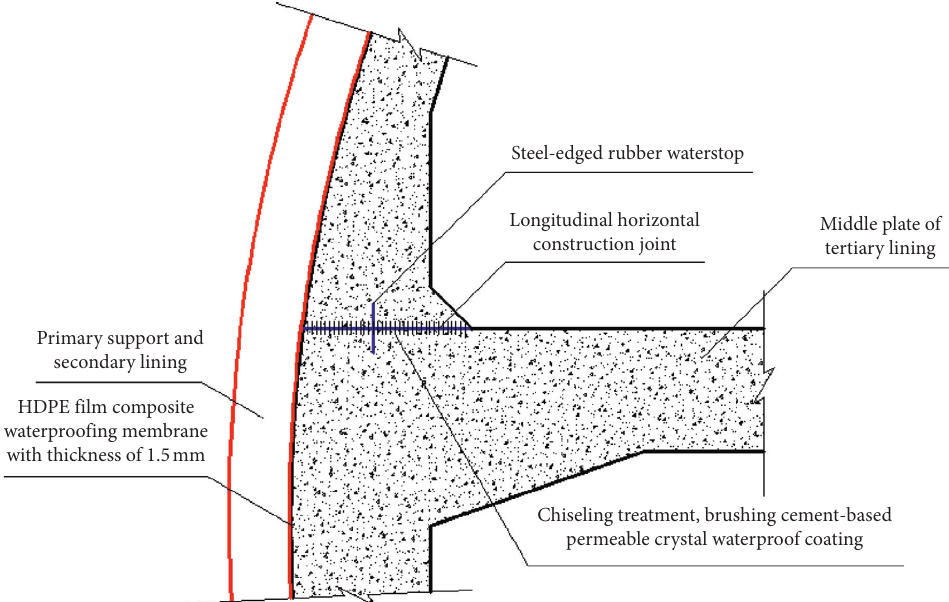
Figure 8: Schematic diagram of the waterproof structure of the longitudinal construction joints.